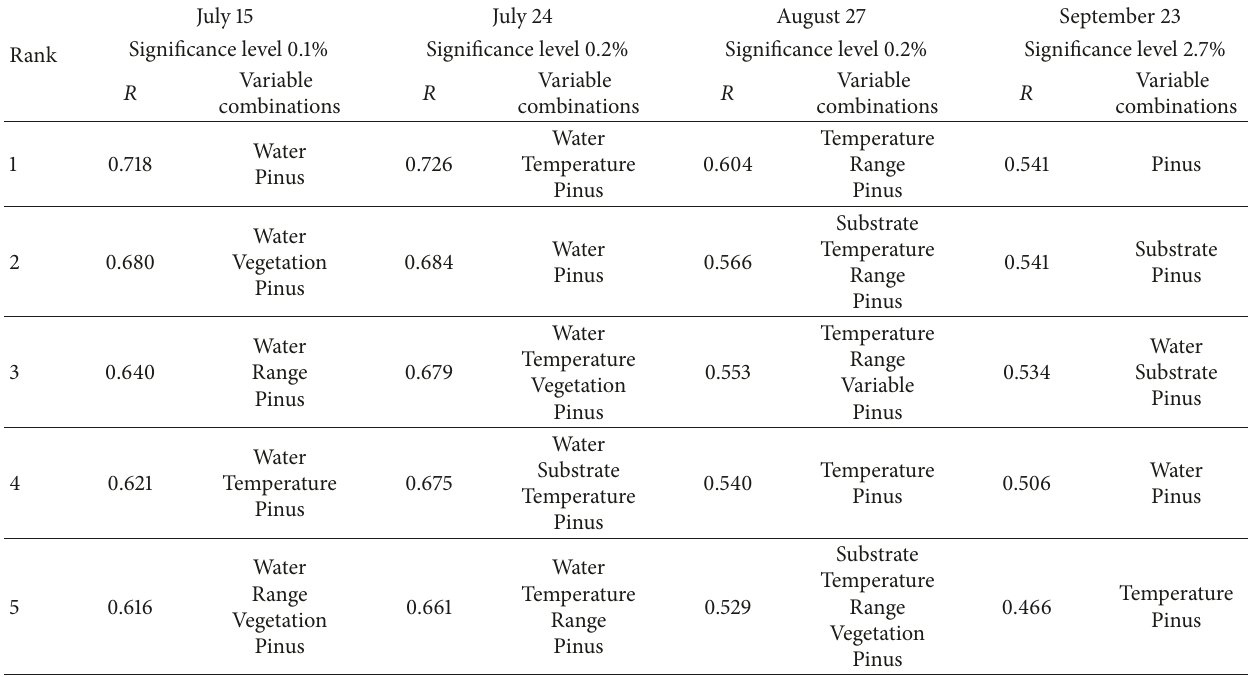
Table 3: Biota-environment (BIO-ENV) analyses identifying the best five sets of environmental predictors explaining carabid beetle compositions on Mt. Hakusan. 𝑅 denotes the Pearson correlation